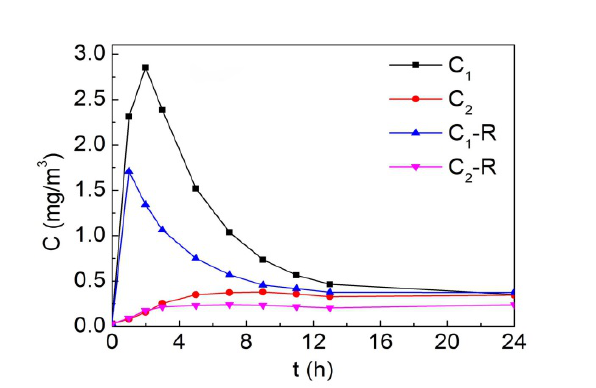
Fig. 3 Diffusion of formaldehyde in different thickness of white cement putties